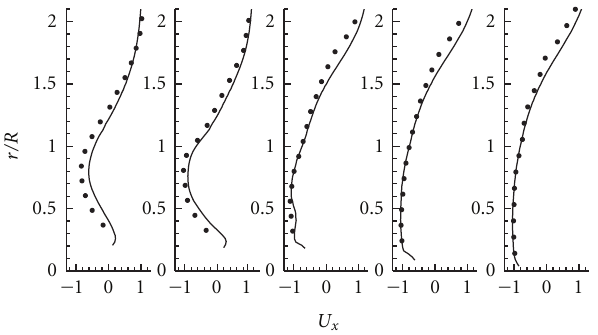
Figure 5: Profiles from circumferentially averaged axial velocity over open propulsor at J = − 0 . 7. Locations of profiles are x/R = − 0 . 39, x/R = − 0 . 25, x/R = 0 . 25, x/R = 0 . 50, and x/R = 0 . 75, respectively (solid line LES, • WT).